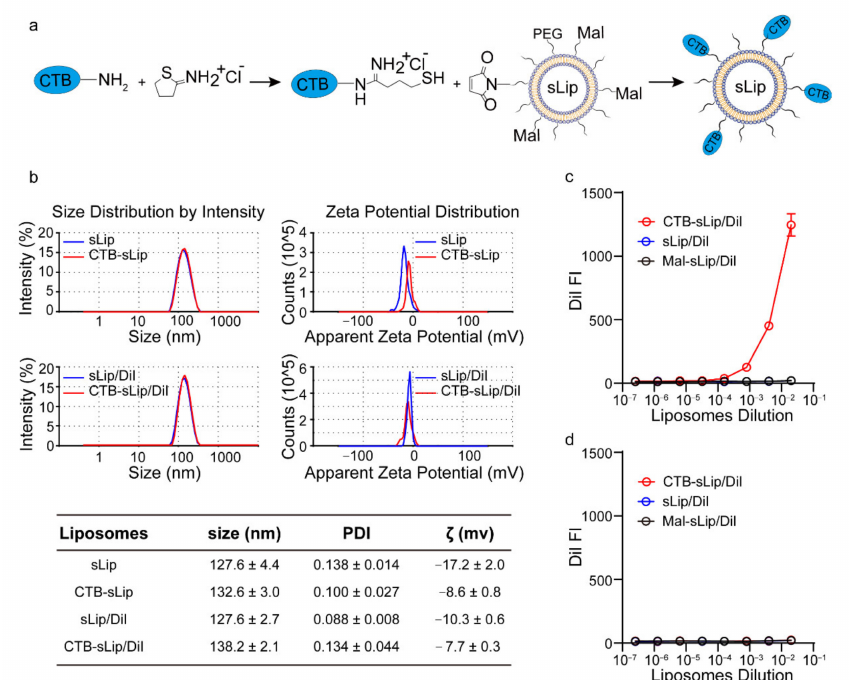
Figure 1. Expression and characterization of the CTB protein. ( a ) Schematically illustration of the structure of CTB. ( b ) Characterization of the expressed and refolded CTB by SDS-PAGE. ( c ) Binding activity of the expressed CTB to GM1; BSA was set as the control. The K d value was calculated using GraphPad Prism 8.0.1. Data are means ± SDs, n = 3.